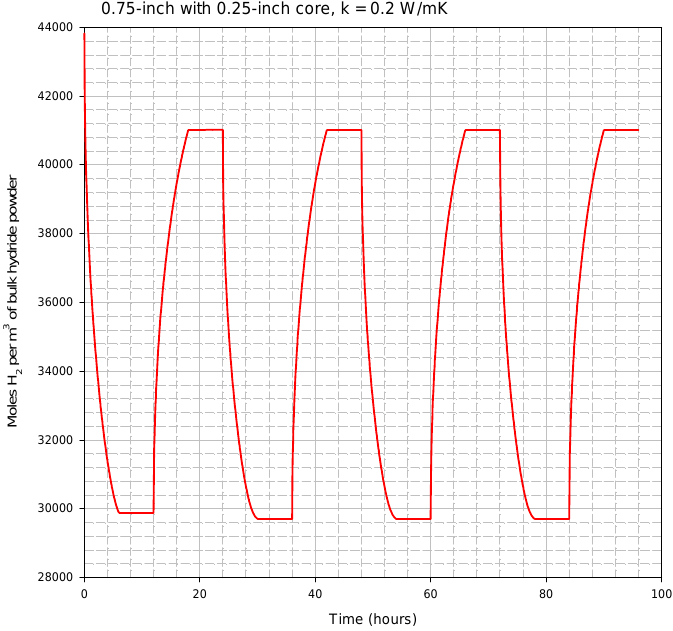
Figure 13. Modeled four complete cycles for the 1.9 cm (0.75 in)-diameter hydride bed. The 55 tubes can be arranged in an array roughly 19 cm (7.5 in) wide, 16.5 cm (6.5 in) high and 46 cm (18 in) long, as shown in Figure 14. Each tube has an inside diameter of 1.9 cm (0.75 in) and an outside diameter of 2.22 cm (0.875 in). The total volume occupied by the array of tubes is 14.4 liters.